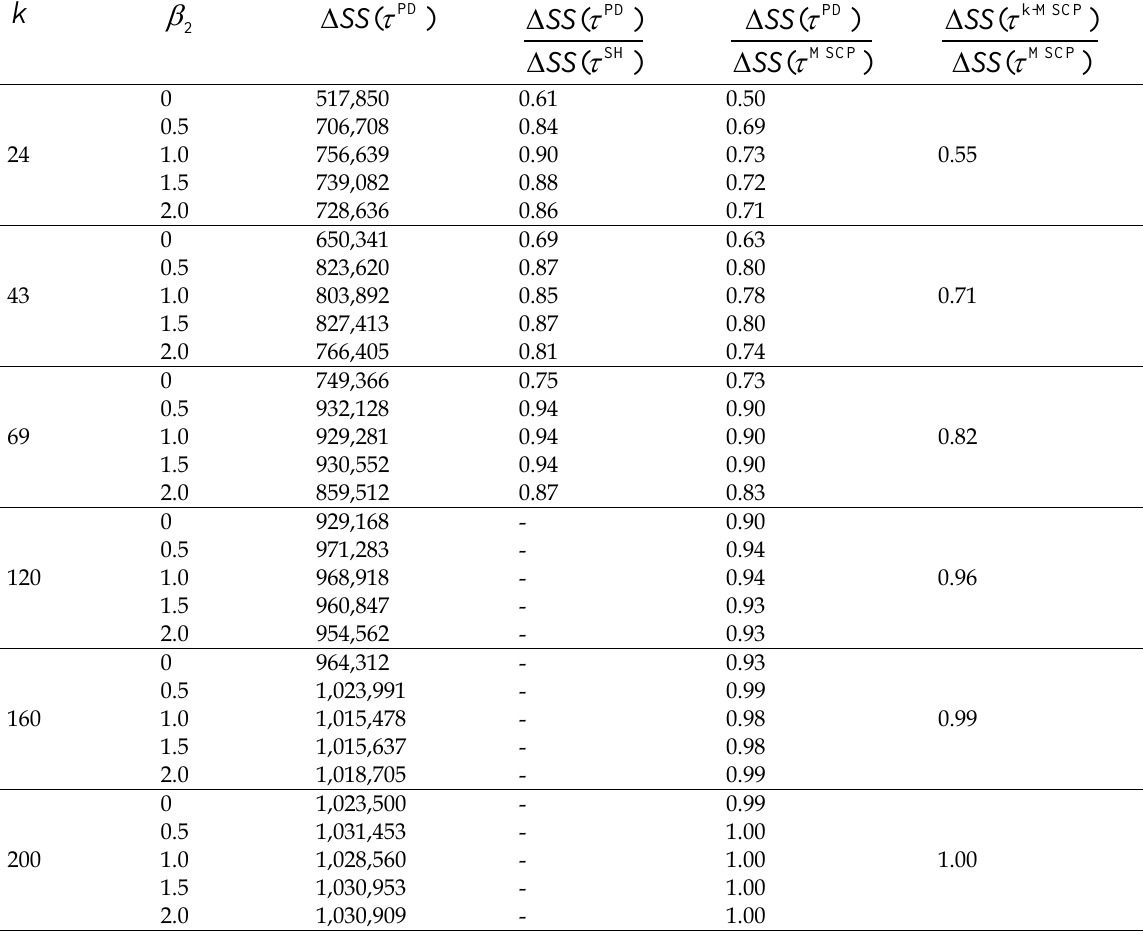
Table 6. Results from solving (13) with the greedy heuristic, and comparison with k-MSCP.